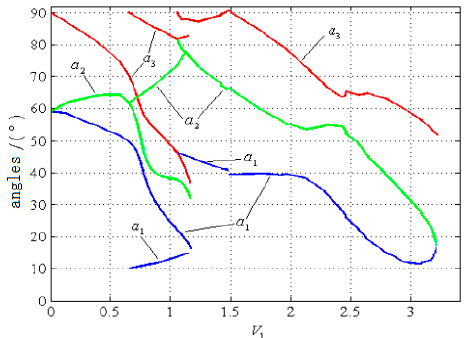
Figure 4. The trajectories of switch angles for each waveband.